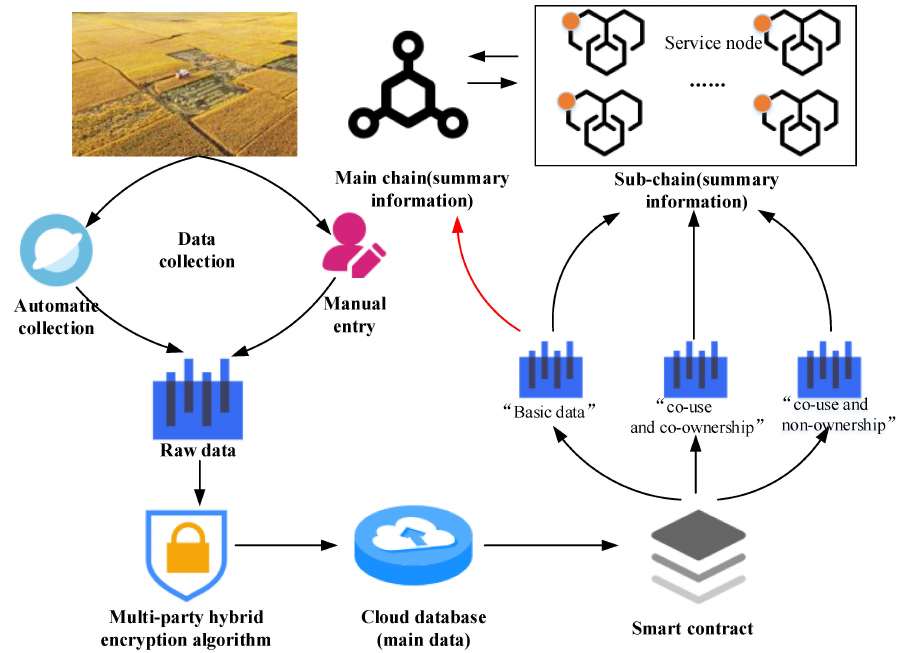
Figure 4. Schematic diagram of multimode storage